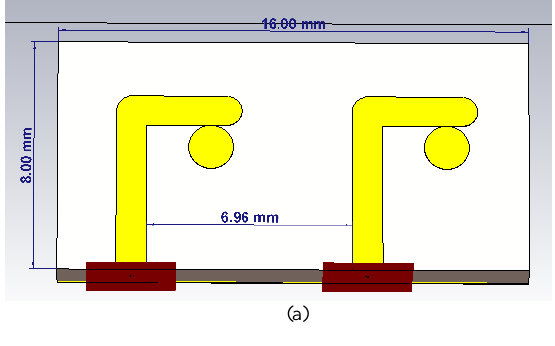
CST Microwave and HFSS.